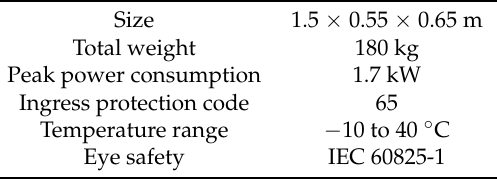
Table 1. Operational parameters.